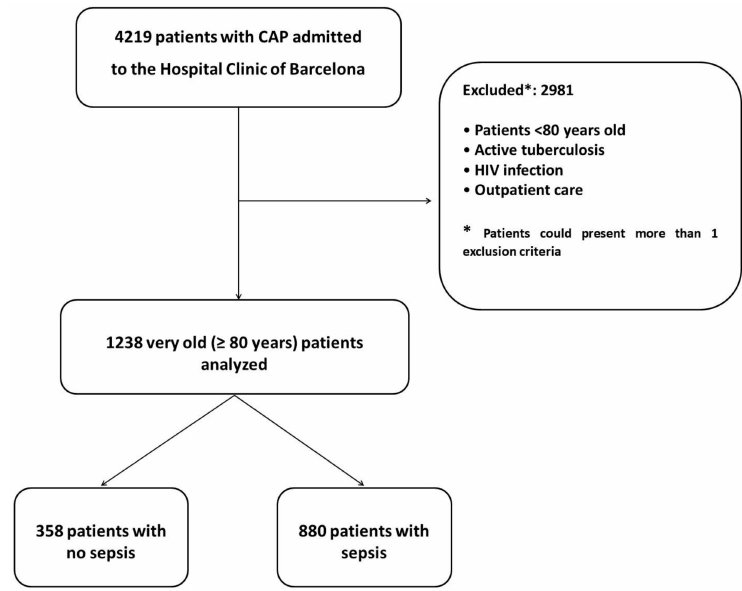
Figure 1. Flow chart of the study